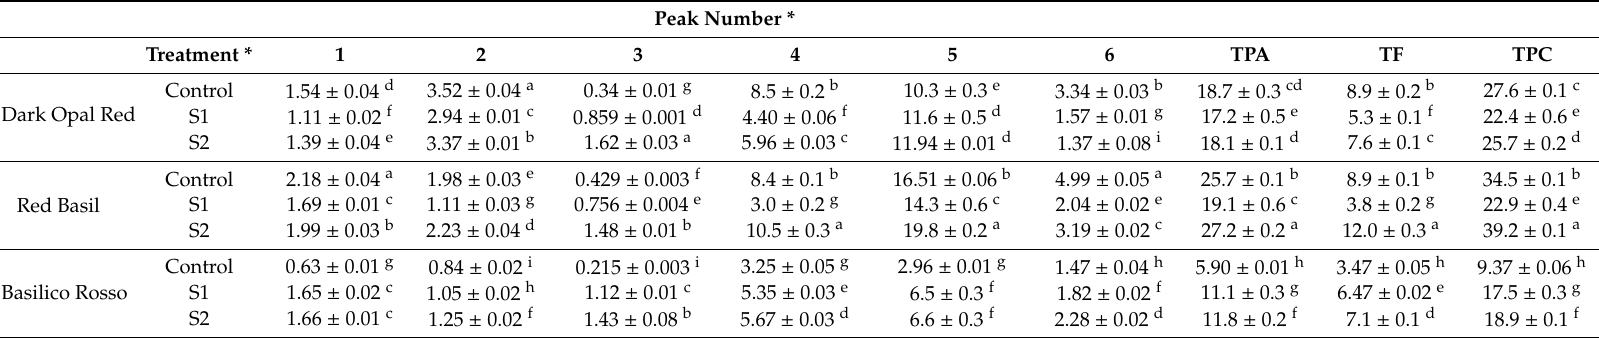
Table 4. Quantification (mg / g of extract) of the phenolic compounds (total phenolic acids, total flavonoids and total phenolic compounds) present in the hydroethanolic extracts of leaves of the tested basil cultivars in relation to salinity level (mean ± SD, n =